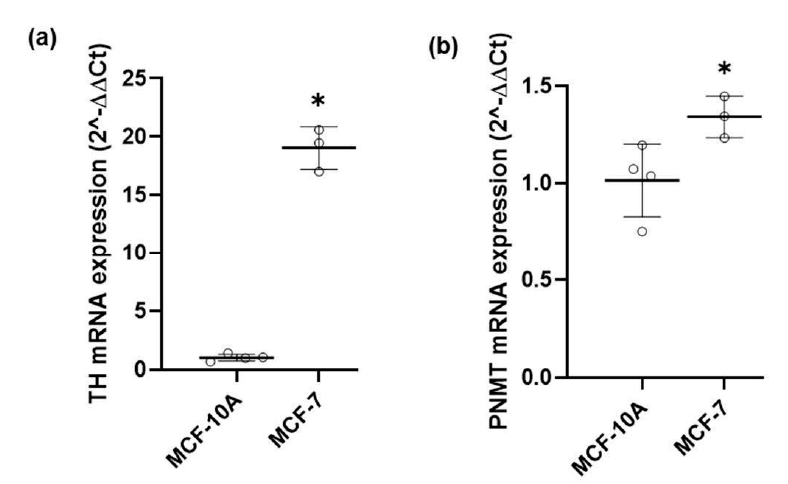
Figure 1. mRNA expression of ( a ) tyrosine hydroxylase (TH) and ( b ) phenylethanolamine N- methyltransferase (PNMT), in MCF-10A and MCF-7 cells, determined using RT-qPCR and normalized to β -actin (Ct values for β -actin are available in Figure S1). Similar results were obtained when normalized to GAPDH. Values are means ± SD from 3 (MCF-10A cells) or 4 (MCF-7 cells) independent experiments. Significant differences from TH or PNMT expression in MCF-10A cells: * p ≤ 0.05 (Student’s t -test).